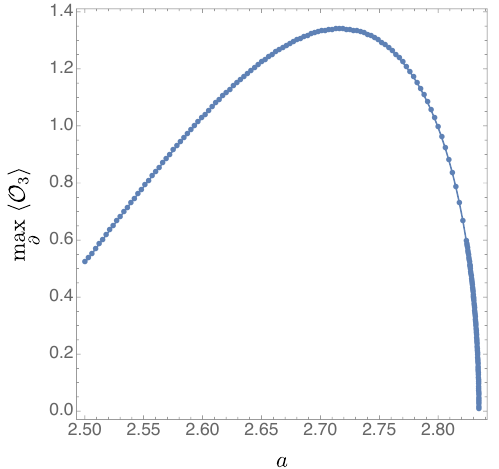
Figure 12 . Solutions with a scalar condensate only exist for amplitudes less than the onset. The data shown here gives the maximum value of the condensate along the boundary for the n = 2 pro(cid:12)le and m = 6 mode. The curve terminates at the left when the solution becomes